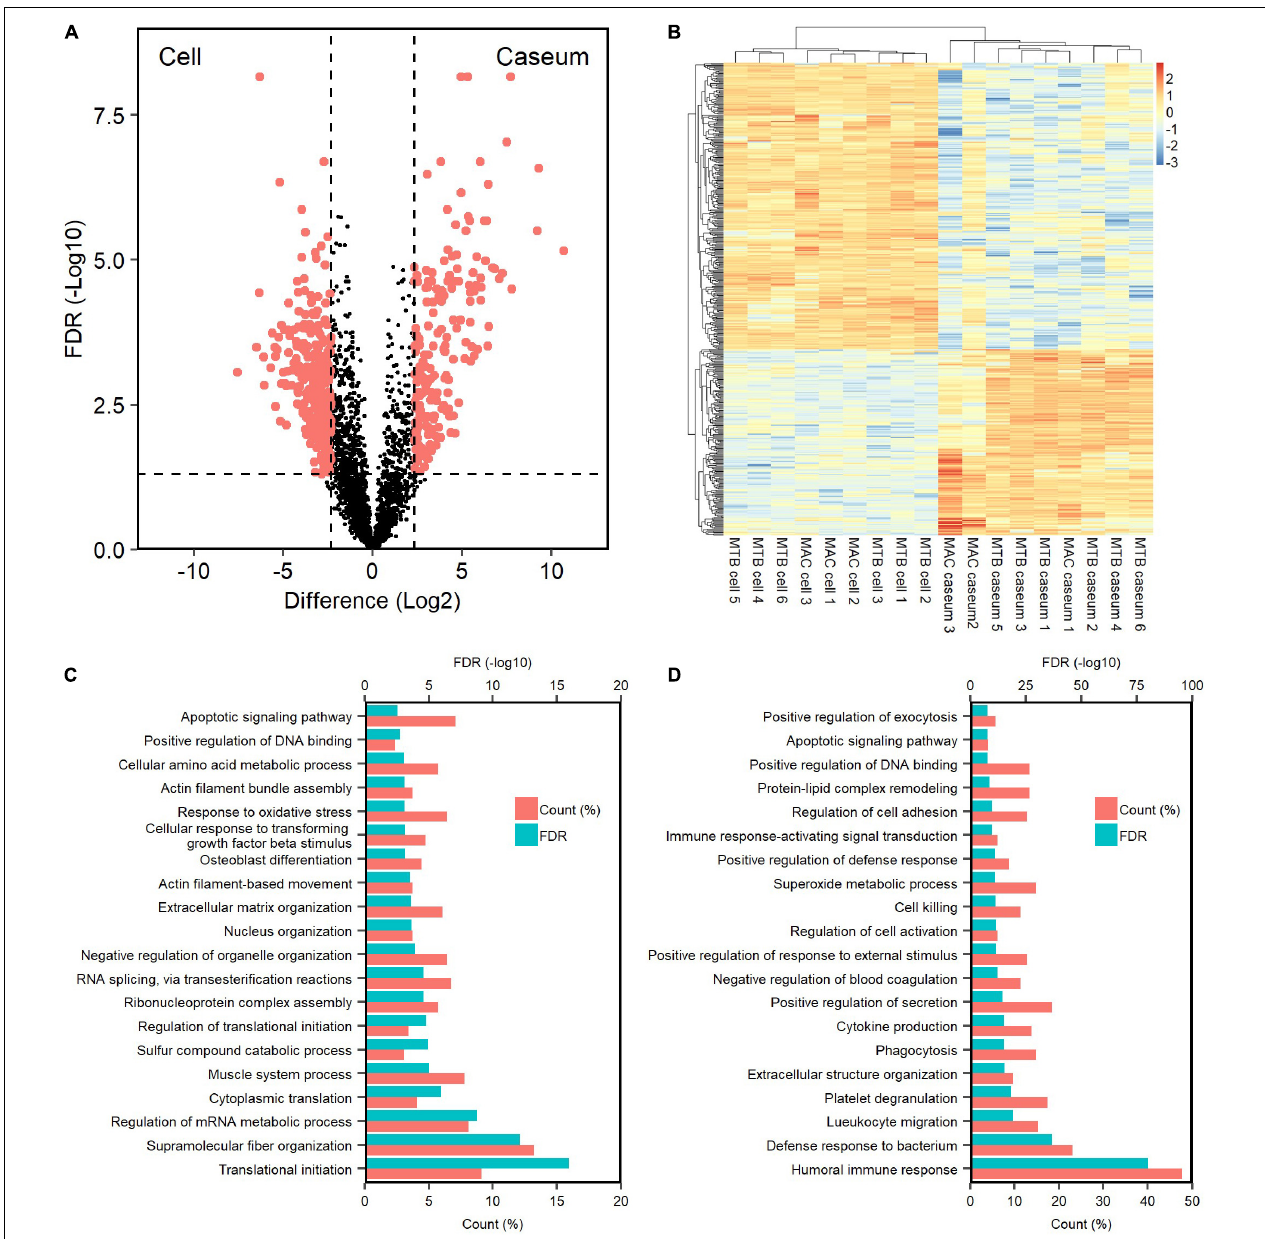
FIGURE 3 | Dynamics of protein composition in granulomatous sub-compartments. (A) Volcano plot of protein abundance between caseous and cellular sub-compartments of granulomatous lesions combined with both TB and MAC-LD. The logarithmic ratios of average fold changes and negative logarithmic FDR values of the Welch’s t -test between samples from caseous and cellular sub-compartments are plotted on the x- and y -axes, respectively. Highlighting dots correspond to proteins with significantly different abundance (FDR < 0.05 and absolute value of fold change > 5). (B) Hierarchical-clustering-based heatmap for proteins with different abundance between granulomatous sub-compartments ( n = 484). GO terms related to biological processes of significantly abundant proteins in Caseum (C) or Cell (D) . Top 20 ranked GO terms are listed. The proportion of identified protein numbers related to indicated GO terms and FDR are also